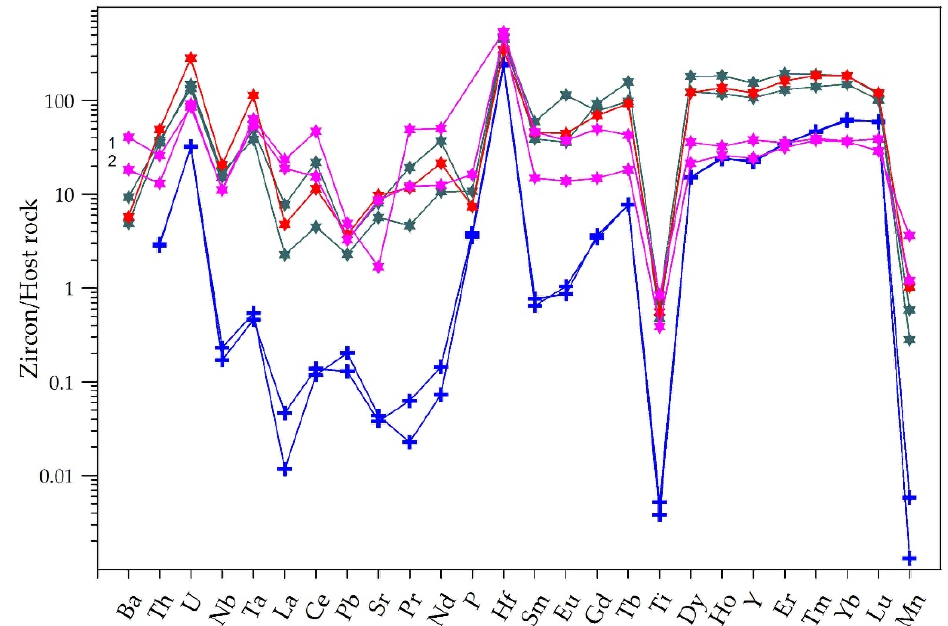
Figure 6. Trace-element distribution patterns for primary and hydrothermal zircon, normalized to the CO-2A host granite sample. Symbols: blue cross—primary zircon; green star—botryoidal aggregates; magenta star—fibro-radiated crypto-crystalline aggregates; brown core—(1), colorless overgrowth (2); red star—spherulitic fibro-radiated micro-crystalline aggregate in allanite-(Ce).